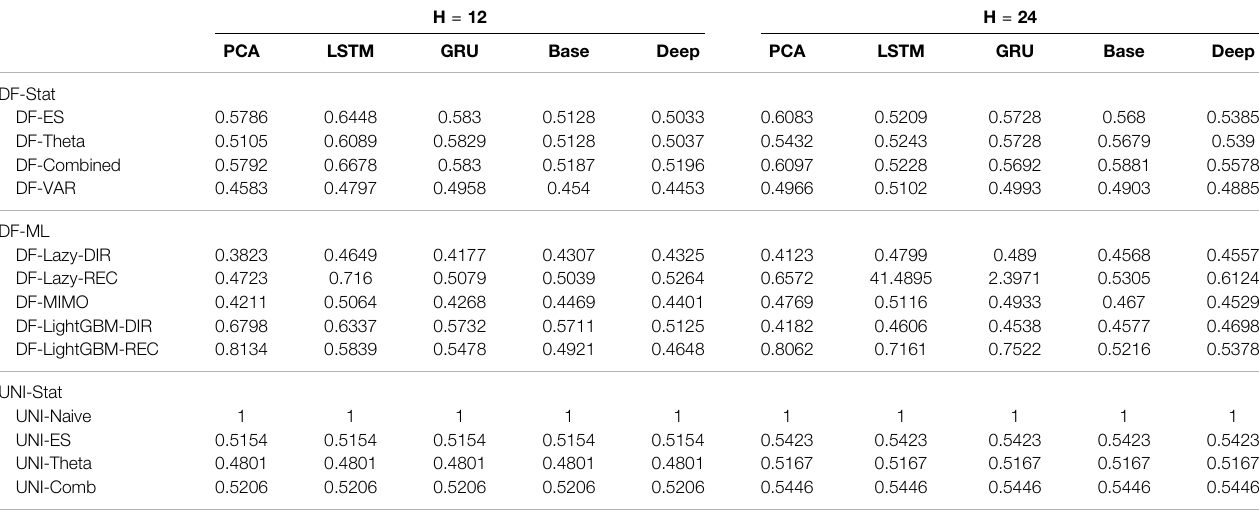
TABLE 7 | Traf fi c Naive Normalized MSE for H ∈ {12, 24}. The content of the cell c ij represents the model using the j th dimensionality reduction technique with the i th forecasting method. The NNMSE for the Naive method is equal to 1. An NNMSE < 1 indicates that the proposed method outperforms the Naive method.